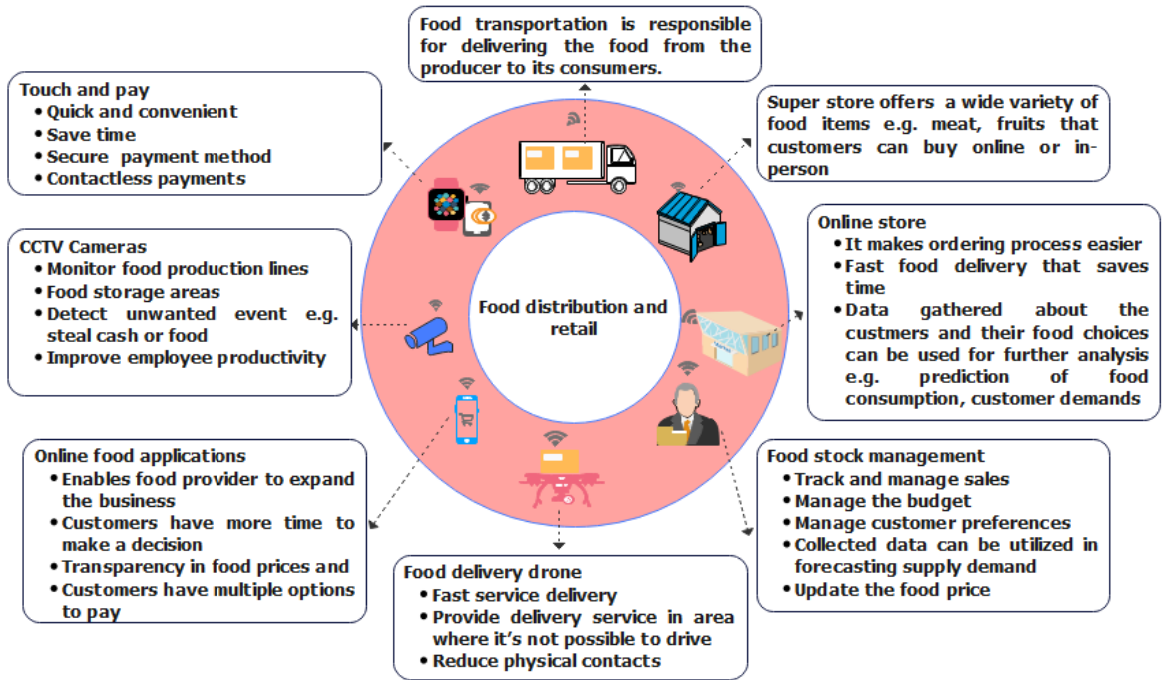
Figure 6. Food distribution and